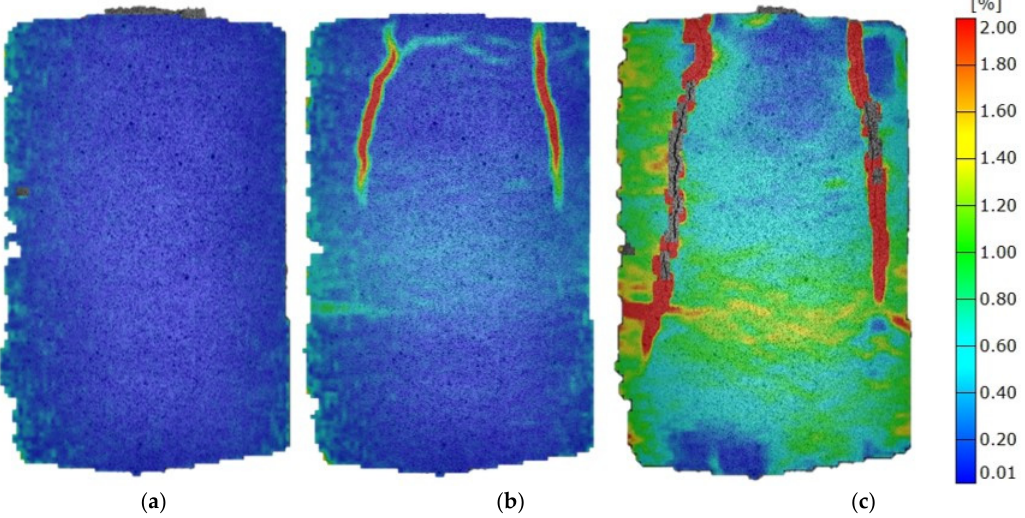
Figure 7. Mises strain at various load stages of mixtures with barley fly ash. ( a ) 0.3 F max ; ( b ) 0.6 F max ; ( c ) 1.0 F max .